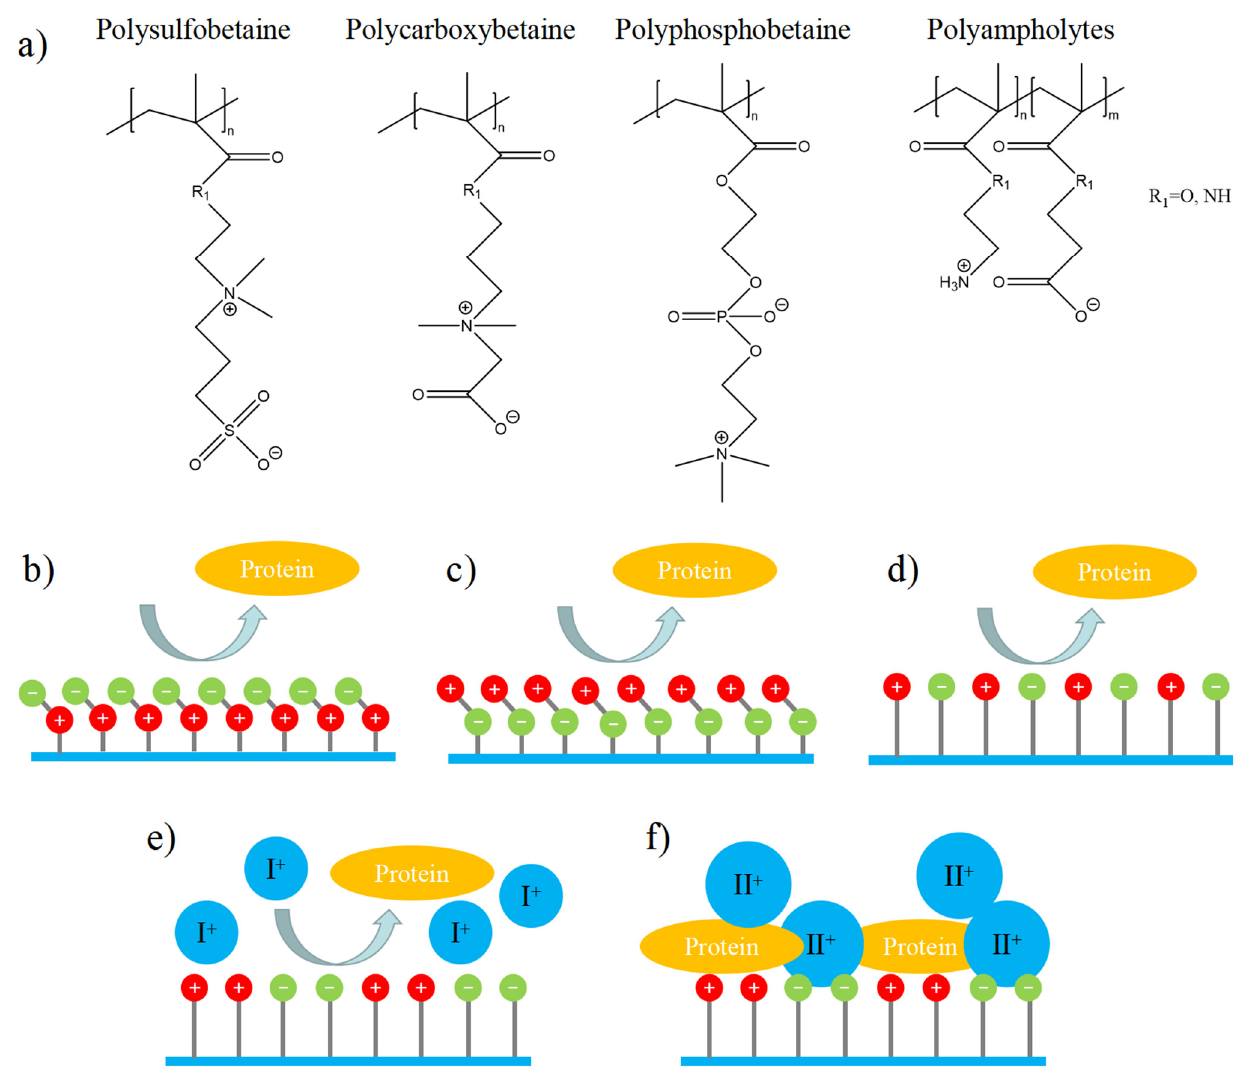
Figure 3. Schematic illustration of common zwitterionic polymers and their antifouling properties. ( a ) Structure of zwitterionic polymers. ( b ) Antifouling property of polybetaine with an anionic terminal group. ( c ) Antifouling property of polyphosphorylcholine with cationic terminal group. ( d ) Antifouling property of polyampholytes with strictly alternating charges. ( e ) Antifouling property of polyampholytes with continuously arranged charge in a monovalent ionic solution. ( f ) Antifouling property of polyampholytes with continuously arranged charge in a multivalent ionic solution .